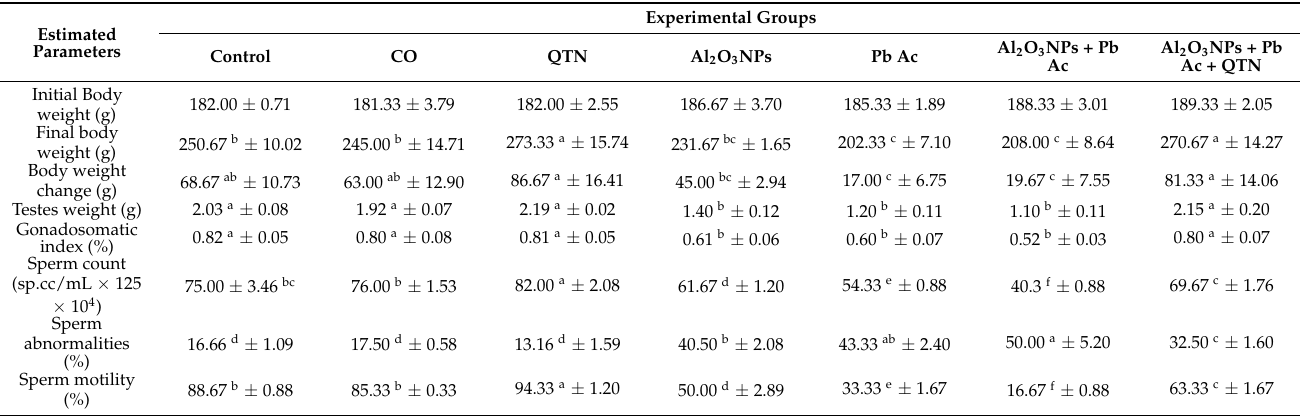
Table 1. Effect of quercetin (QTN) oral dosing on body weight change, gonadosomatic index, and sperm characteristics of adult male Sprague Dawley rats exposed to aluminum trioxide nanoparticles (Al 2 O 3 NPs) and/or lead acetate (Pb Ac) for 60 days.